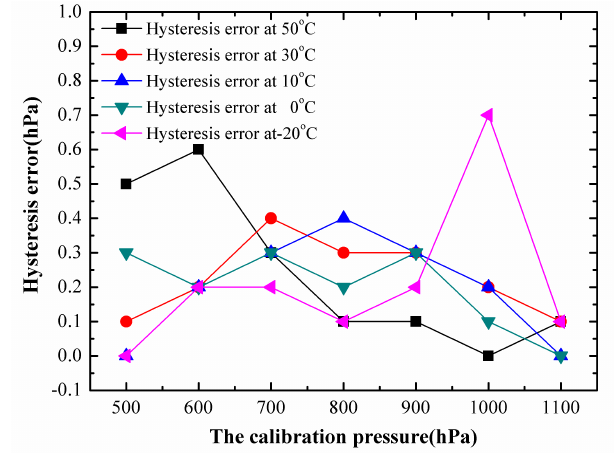
Figure 10. The hysteresis error after compensation by using the GA-WNN algorithm at 50 °C, 30 °C, 10 °C, 0 °C, and − 20 °C.